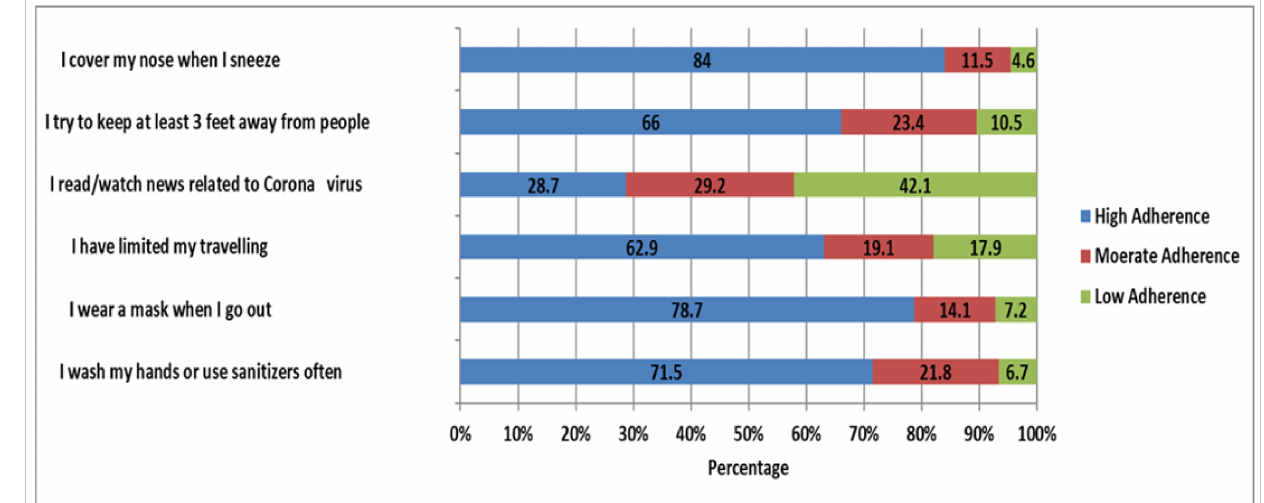
Figure 1. Adoption of Precautionary Behaviors to Prevent Coronavirus Disease Transmission ( n =